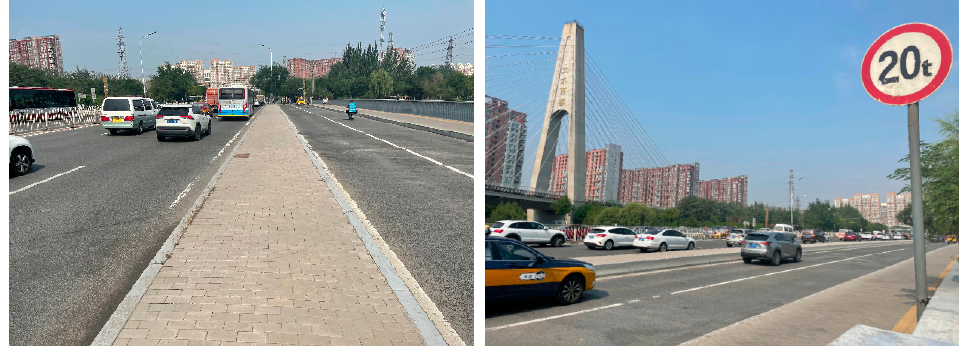
Figure 3. Diagram of the case bridge.